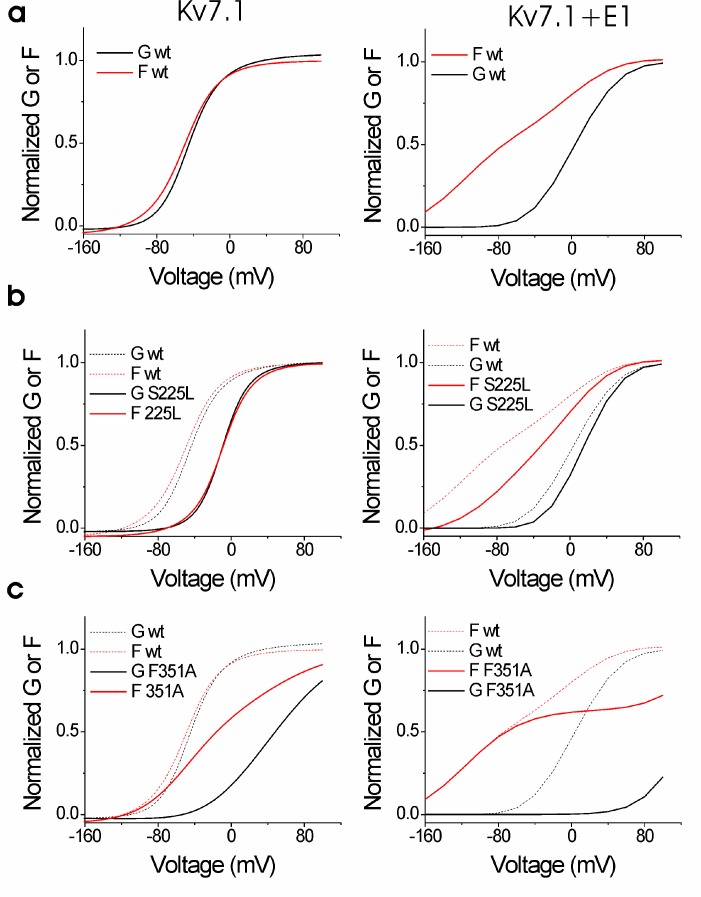
Simulations of wild-type and mutant KV7.1 and KV7.1+KCNE1 channels reproduce currents and fluorescence.Simulated G(V) (black) and F(V) (red) curves for (a) wild-type, (b) S225L, and (c) F351A KV7.1 (left) and KV7.1+KCNE1 (right) channels using the KV7.1 and KV7.1+KCNE1 models in Figure 3—figure supplement 1. Parameters for the wild-type models were determined in earlier studies (see Supplementary file 4 for all rate constants). Current and fluorescence traces were simulated using Berkeley Madonna (Berkeley, CA).